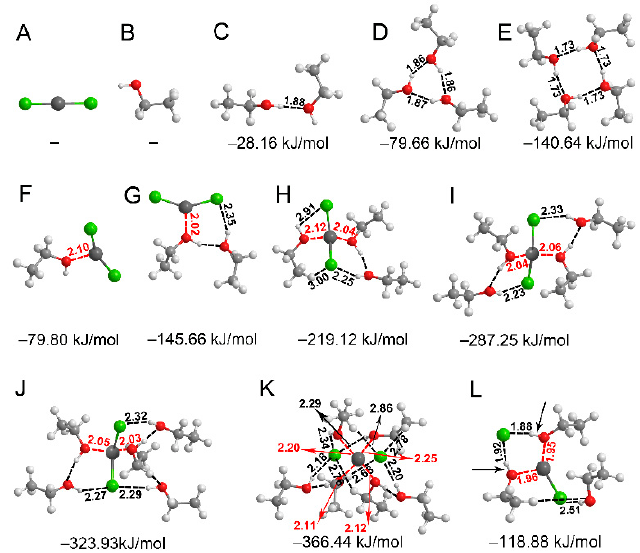
Figure 2. Optimized geometries and interaction energies of ZnCl 2 ( A ), monomer to tetramer of EtOH ( B – E ), ZnCl 2 - n EtOH complexes with n = 1–6 ( F – K ) and a 1:3 molecular ratio complex containing two LRS-OHs marked with black arrows ( L ). The optimization was at the B3LYP-D3/6-311++G(d,p) level of theory. The black and red broken lines respectively indicate the lengths of H-bonds and Zn ← O coordination bonds/spodium bonds in the unit of Angstrom